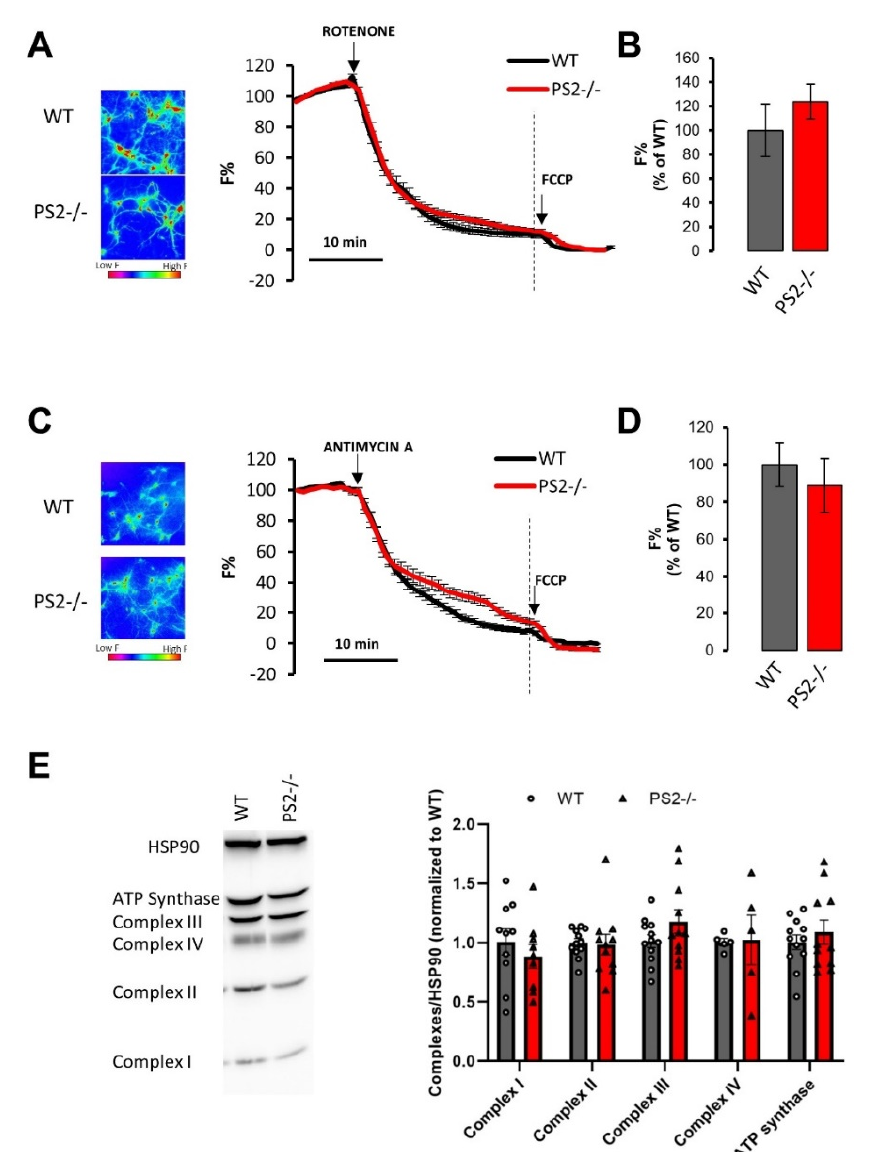
Figure 4. The lack of PS2 does not affect ΔΨ m and the expression levels of the different respiratory chain complexes. ( A – C ) Average traces of WT (black) or PS2–/– (red) cortical neurons loaded with tetramethyl rhodamine methyl ester (TMRM), bathed in mKRB and exposed to rotenone (1 µm, panel A ) or antimycin A (1 µm, panel C ) for 30 min and carbonyl cyanide-4-(trifluoromethoxy)phenylhydrazone (FCCP) (10 µ m) for 10 min. Data are shown as mean ± SEM of F% obtained in WT (rotenone: n = 59 cells of 5 independent cultures; antimycin A: n = 117 cells of 5 independent cultures) or PS2–/– (rotenone: n = 85 cells of 5 independent cultures; antimycin A: n = 67 cells of 5 independent cultures) cortical neurons. The TMRM fluorescence, at rest, was visual- ized by employing a pseudocolored scale that starts from blue-purple, low TMRM accumulation, and turns to yellow-red, high TMRM accumulation (as shown by the calibration bar), in panels A and C (left part). ( B – D ) The bar graph shows the mean ± SEM of F%, as a percentage of WT, obtained in WT (gray) or PS2–/– (red) cortical neurons upon rotenone ( B ) or antimycin A ( D ) addition, calculated at the time point indicated by the dashed line of panel ( A ) or ( C ), respectively. ( E ) Representative Western blot of respiratory chain complexes and ATP synthase levels in WT and PS2–/– neurons. The scatter plots show the mean values ± SEM of 9 independent cultures for WT and 7 independent cultures for PS2–/–, run in duplicate. Values were first normalized by their internal HSP90 levels and then to those of WT